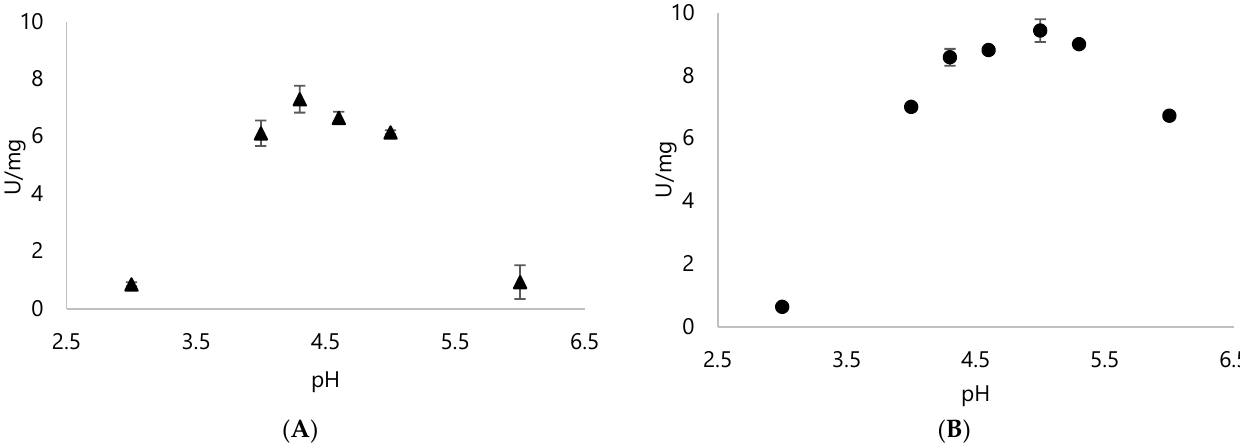
Figure 3. Specific activity of ( A ) DypA and ( B ) DypB with 1 mM ABTS as the substrate and 0.25 mM H 2 O 2 using Britton-Robinson buffer with pH ranges from pH 2 to 6 to check the optimal pH for each enzyme.